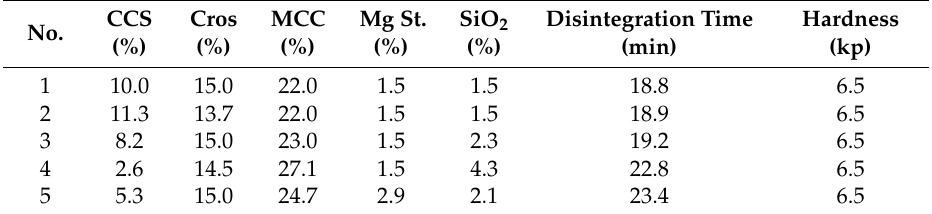
Table 4. Optimal points obtained from the design spaces for Wuzi Yanzong extract tablet formulation containing 50% Wuzi Yanzong dry powder extract and the resulting response, disintegration time, and hardness.